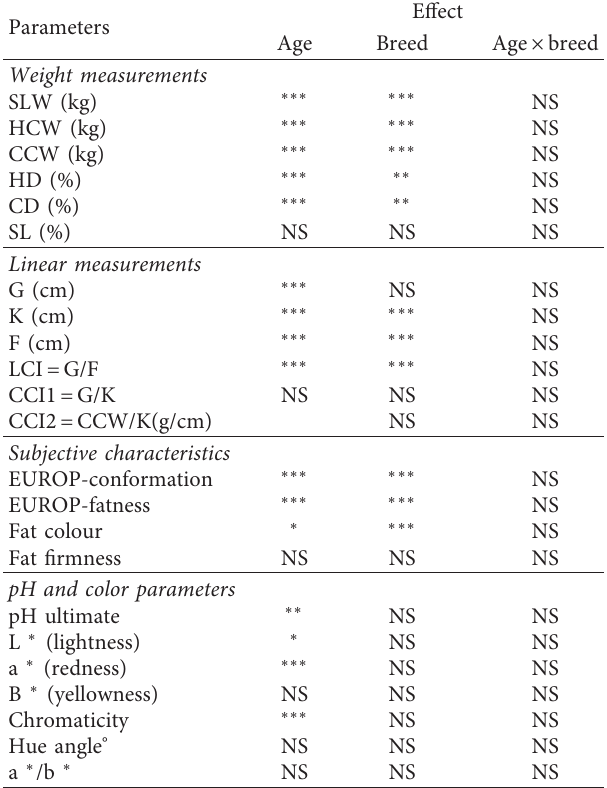
Table 3: Effect of breed, slaughter age, and their interaction on carcass traits and meat quality of Beni-Guil and Ouled-Djellal sheep breed from eastern Morocco.